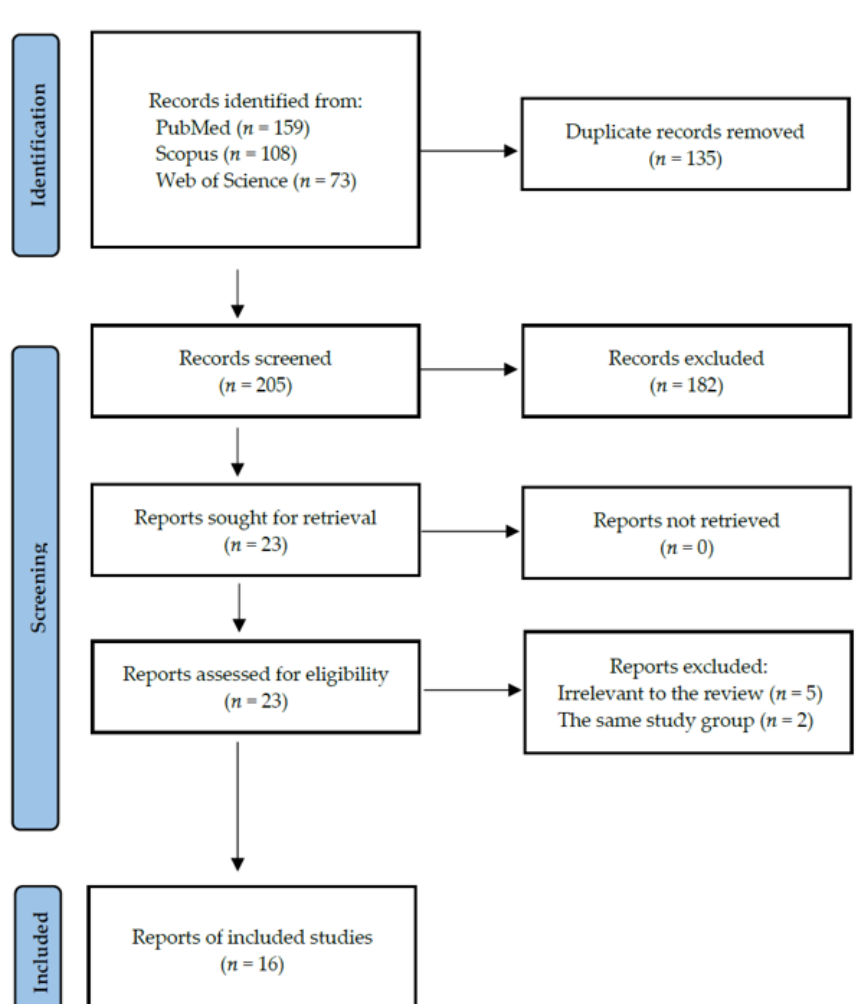
Figure 2. PRISMA flow diagram representing the search strategy.